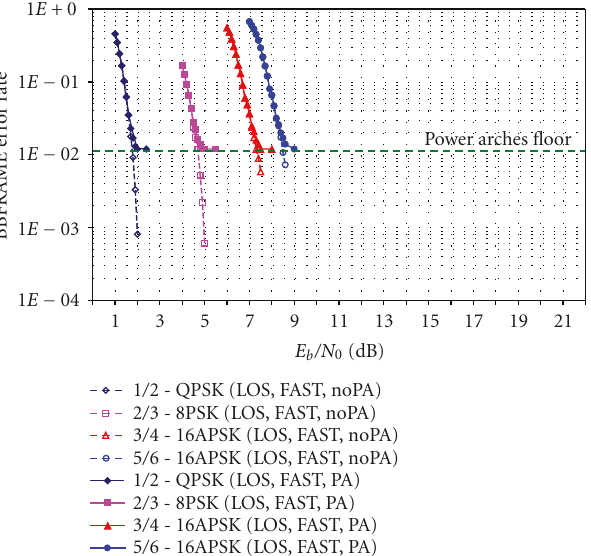
Figure 3: BBFRAME error rate for DVB-S2 in the presence of power arch blockage events. LOS propagation conditions and train speed set to 300